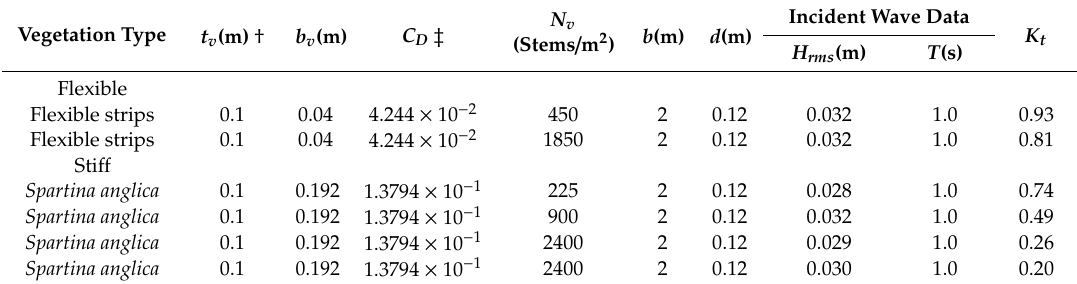
Figure 10. Comparison of K t for the experimental results of Bouma et al. [18] and present computations (the meaning of the solid line: K t (Present results) − K t (Exp. Results, Boumaet al. [18]) = 0; the meaning of the range of dashed lines: the calculation error of K t is within 5%). Table 4. Physical properties of plant characteristics and wave data for experimentation.